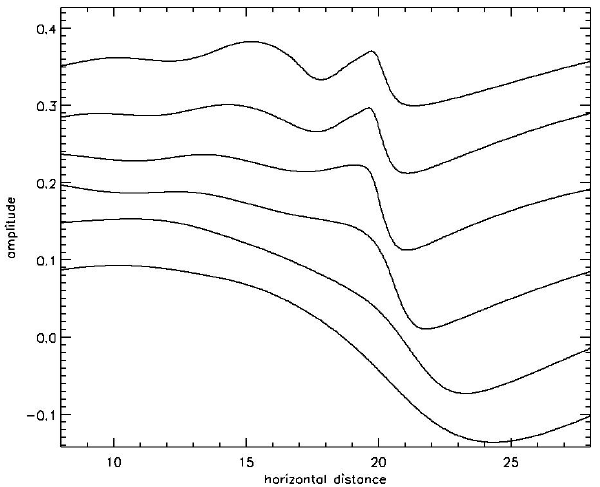
Fig. 13. The same data as in Fig. 12 except shown for the full hori- zontal computational domain.